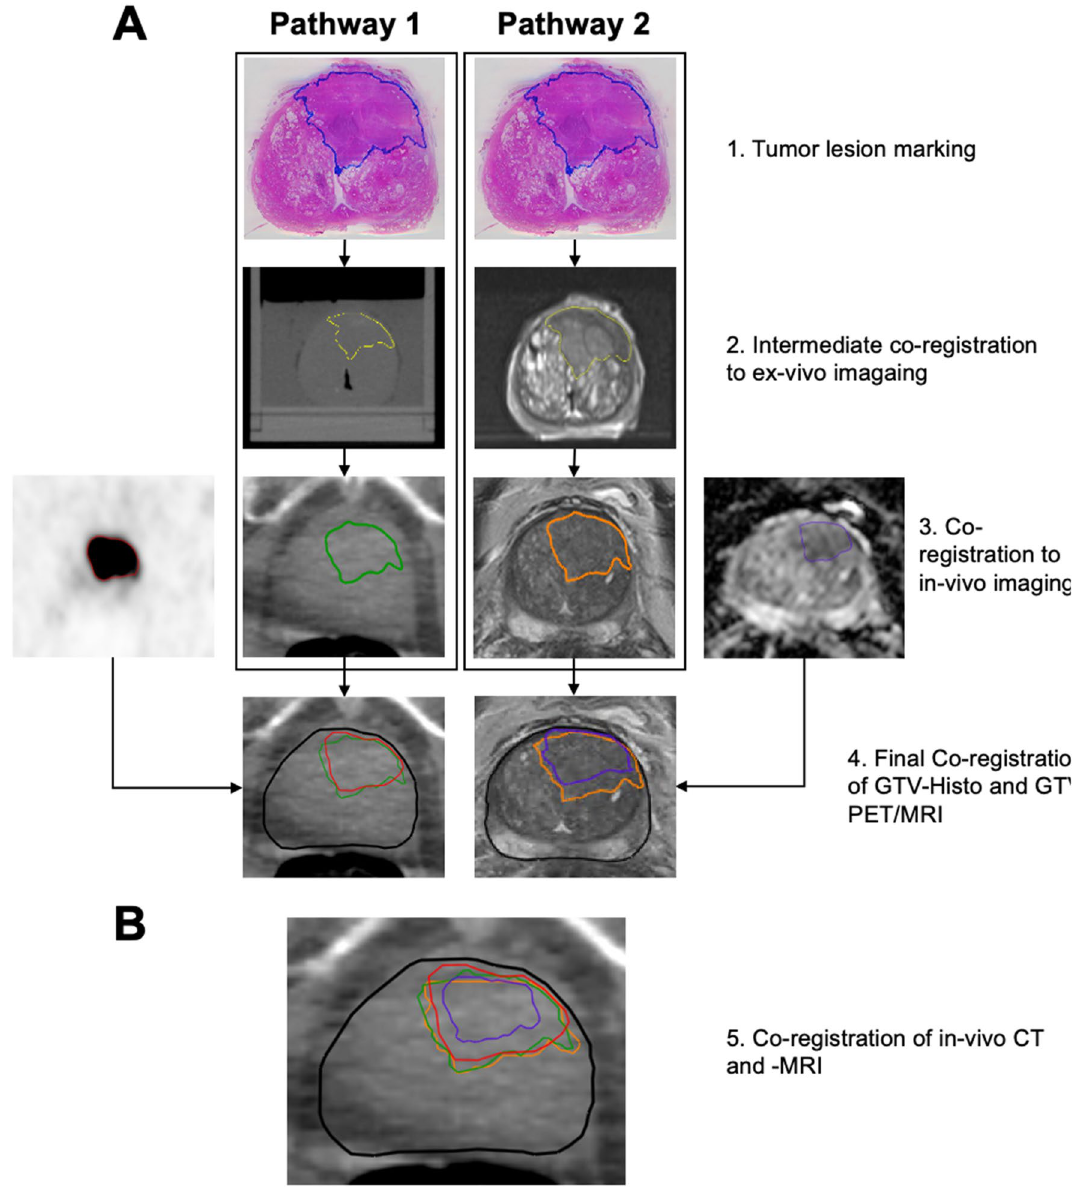
Figure 2. Illustration of the two pathways for co-registration of histopathological slices with in-vivo imaging. ( A ) shows co-registration workflow via intermediate ex-vivo CT (1) and ex-vivo MRI (2) imaging. First row shows H&E stained whole mount prostatectomy specimen with intraprostatic tumor lesions marked in blue. Second row shows intermediate GTV-Histo 1 and GTV-Histo 2 on ex-vivo CT (1) and ex-vivo MRI (2) in yellow (created in MITK Workbench 2015.5.2). Correct localisation of specimen slices was based on the 4 mm grid attached to the side walls of the localizer as well as anatomical landmarks. Third row shows GTV- Histo 1 (green) and GTV-Histo 2 (orange) after final co-registration with in-vivo CT (1) and in-vivo MRI (2). Additionally GTV-PET (red) in diagnostic [ 18 F]PSMA-1007-PET/CT and GTV-MRI (purple) in diagnostic MRI (DWI ADC map) are shown. Fourth row shows GTV-Histo 1 (green), GTV-PET (red) and GTV-MRI (purple) in in-vivo CT (1) and in-vivo MRI (2) after final co-registration. ( B ). After manual co-registration of in-vivo CT and in-vivo MRI allowing non-rigid deformation, GTV-Histo 1 (green), GTV-Histo 2 (orange), GTV-MRI (purple) and GTV-PET (red) were superimposed on the corresponding in-vivo-CT